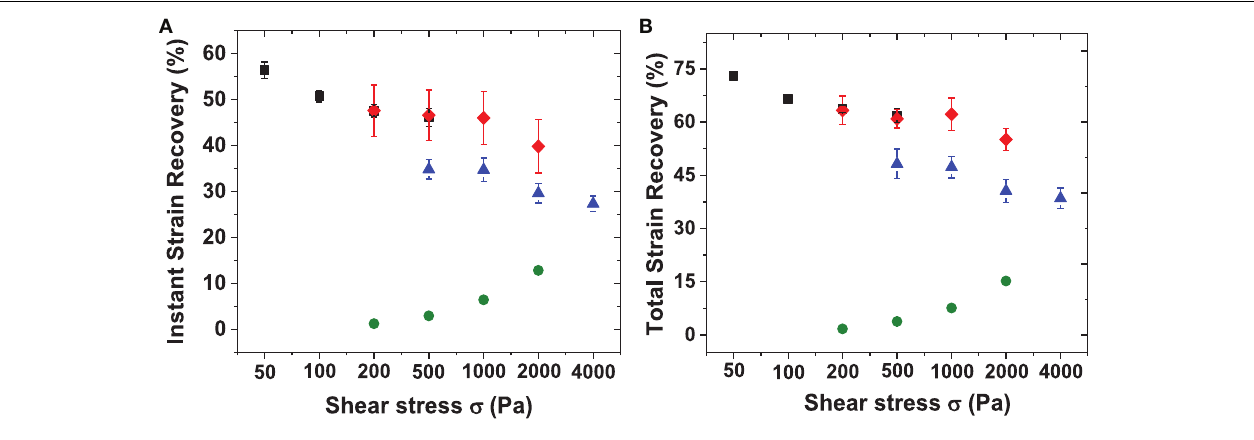
FIGURE 8 | Summary of instant and total strain recovery for RLP and PEG hydrogels upon removing the applied shear stresses. Both instant and total strain recoveries were normalized to the highest strain reached before removal of the applied shear stresses. (A) Instant stain recovery at